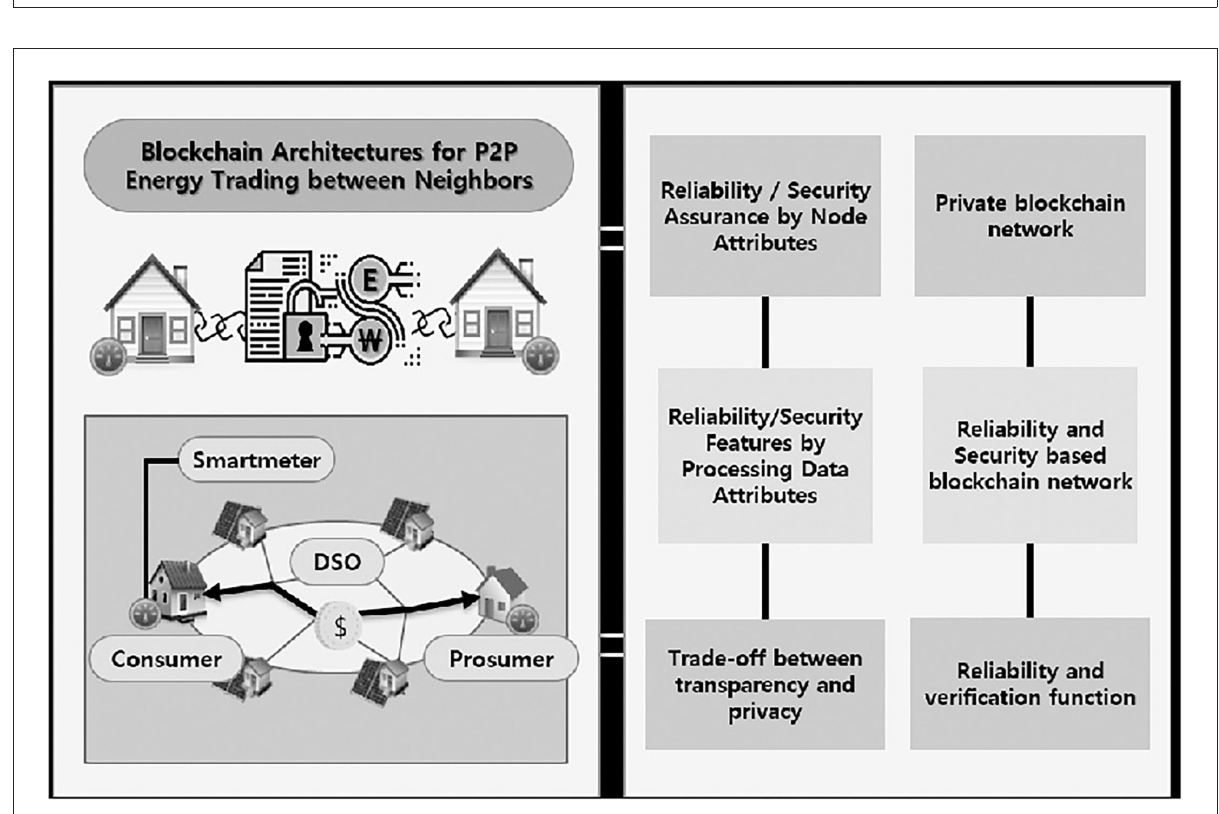
FIGURE9 Blockchain-based architecture for P2P energy trading between neighbors (Lee et al., 2019).